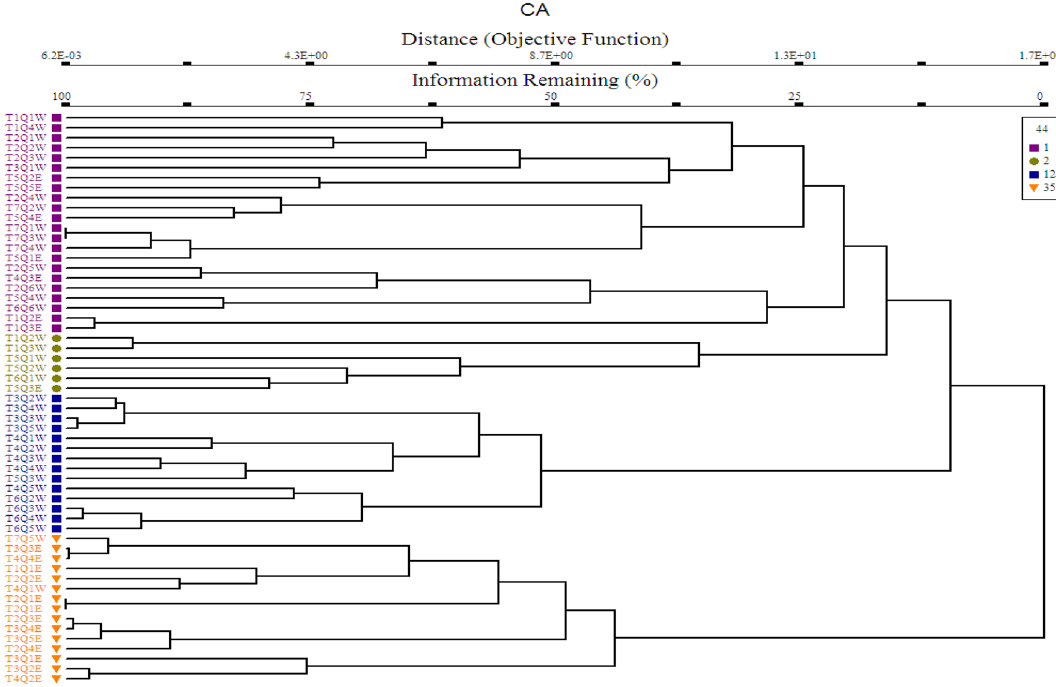
Figure 5. Cluster analysis classified all the stations quadrats into 4 major